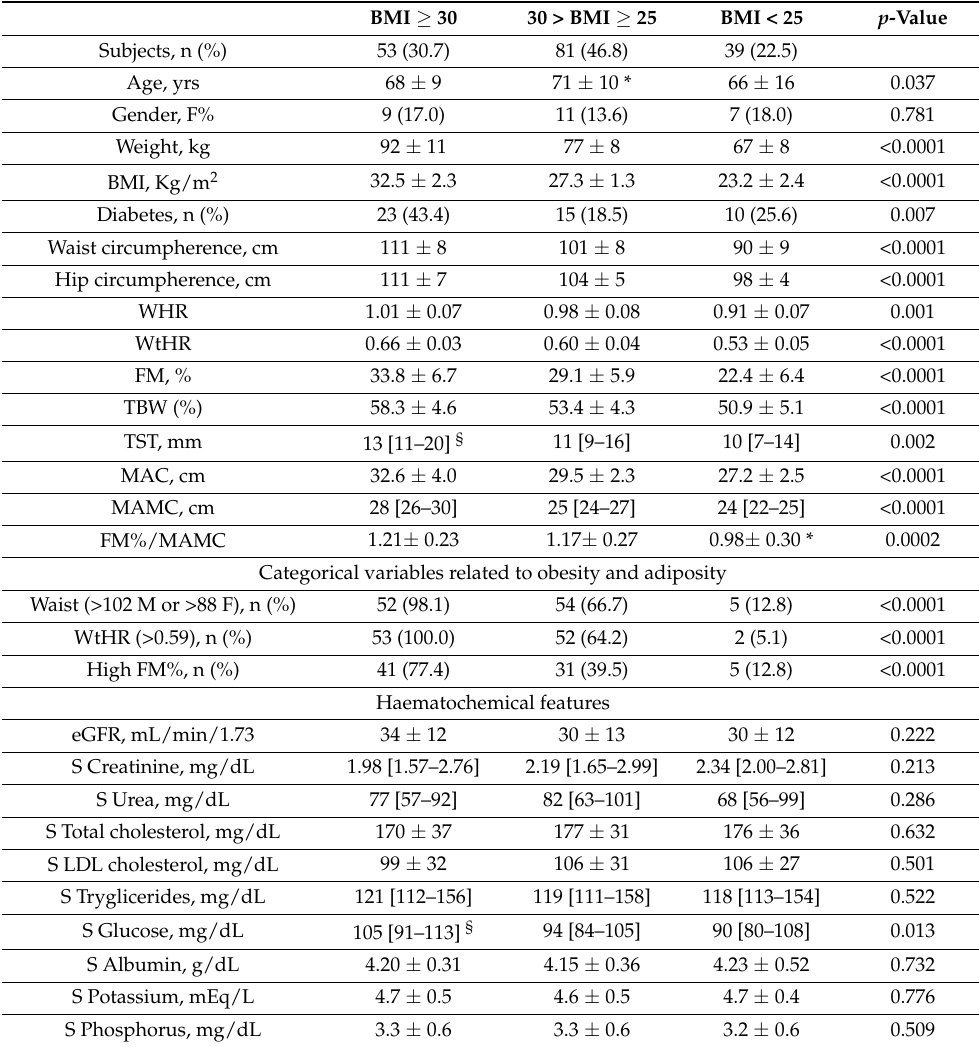
Table 1. Baseline features of patients consecutively enrolled in the study. Anthropometric and laboratory values are reported as mean ± SD, median [IRQ] or n